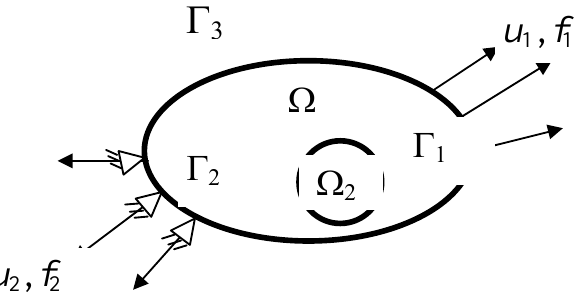
d Arora [6] introduced